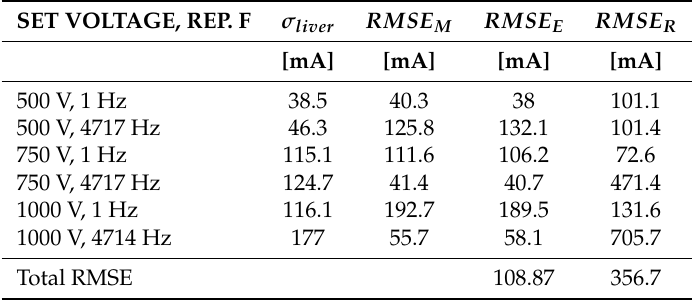
Table 4. The performance summary table displays the root mean square error between measurements on beef liver and mathematical model ( RMSE M ), or prototype emulator ( RMSE E ) or resistor ( RMSE R ) and mean standard deviation of five measurements on beef liver ( σ liver